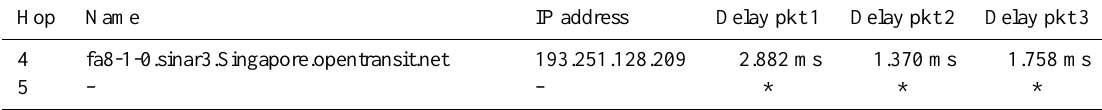
Table 4. Traced route via Singapore (sea-cable operated by Singapore Telecom towards Indonesia) towards host at BMKG’s Jakarta premises in Indonesia on 26 May, approx. 06:30UTC. The trace shows that the route is broken at the hop towards Indonesia, thus rendering Indonesia unreachable from commercial ISP networks using this route. For illustration purposes the remainder of the route is added and marked red, based on a trace several weeks after the